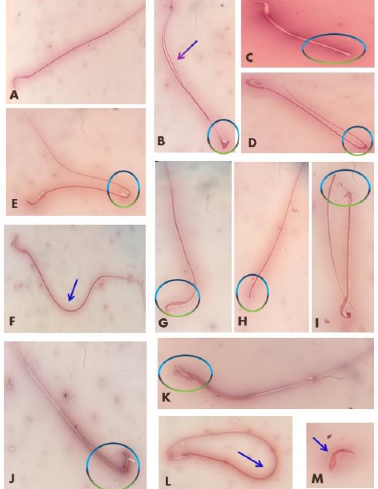
Figure 1. Abnormal spermatozoa induced in rats exposed to Al 2 O 3 NPs and/or PbAc. ( A ) Normal sperm, ( B ) amorphous head with double tail, ( C ) short tail, ( D ) long tail, ( E ) bent tail, ( F ) curved tail, ( G ) bent head, ( H ) detached head, ( I ) broken tail, ( J ) broken head, ( K ) flattened head, ( L ) looped tail, ( M ) detached tail. On the other hand, co-administration of QTN with Al 2 O 3 NP s and PbAc significantly ( p < 0.05) alleviated the decreases in spermatozoa motility (28.58%) and sperm cells con- centrations (7.11%) and significantly dropped the abnormal spermatozoa percentage (95.08%) relative to control group.